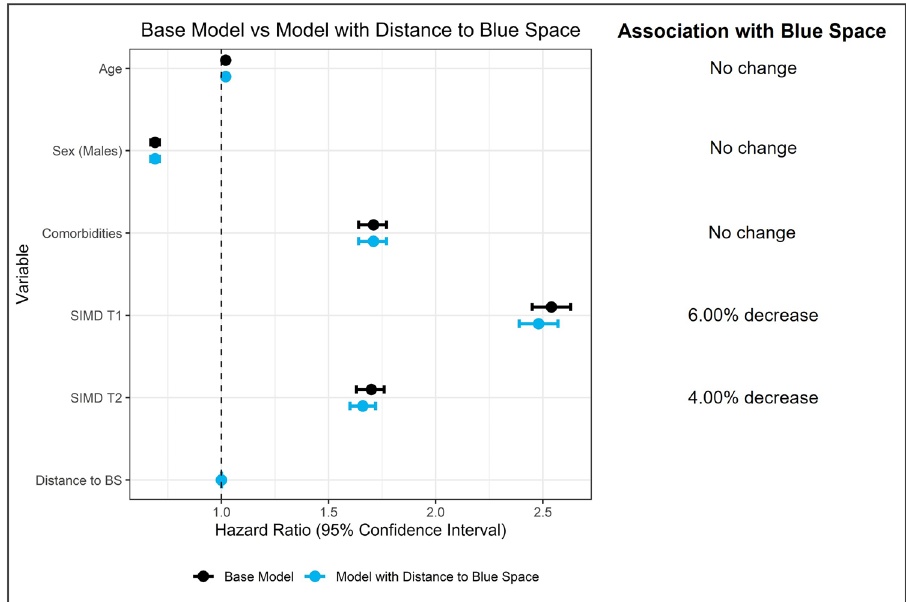
Figure 5. Forest plot of modifying effect of living near blue space on predictors of the risk of mental health